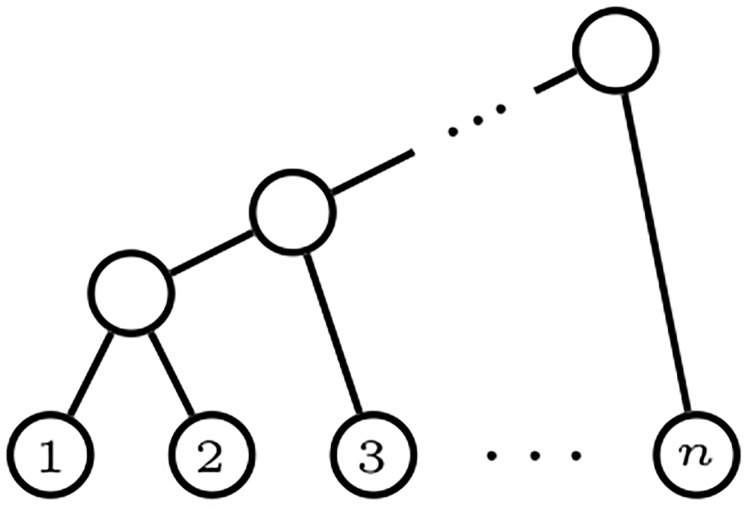
A comb Kn with n leaves.